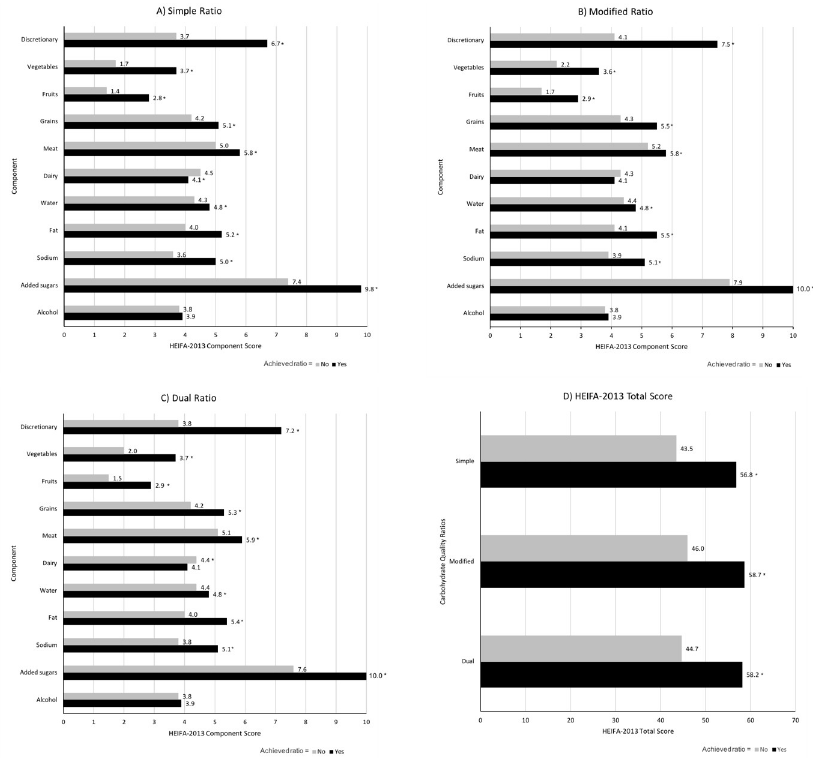
Fig 1. Healthy Eating Index for Australian adults (HEIFA-2013) 11 component scores and total score for adults in the 2011–2012 Australian National Nutrition and Physical Activity Survey (NNPAS) who achieved or did not achieve each carbohydrate quality ratio. (A) Simple ratio (10:1), at least 1g of fiber per 10g of carbohydrates; (B) Modified ratio (10:1:2), at least 1g of fiber and no more than 2g of free sugars per 10g of carbohydrates; (C) Dual ratio (10:1 & 1:2), at least 1g of fiber per 10g of carbohydrates and no more than 2g of free sugars per 1g of fiber; and (D) HEIFA-2013 total scores. ��� P < 0.001 compared to adults who did not achieve the ratio, derived by independent samples